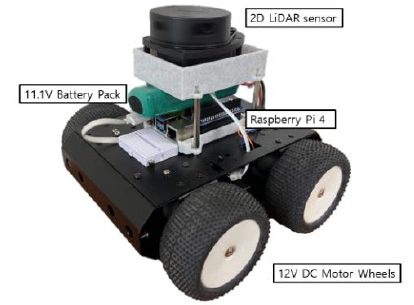
Figure 8. Autonomous Vehicle with LiDAR. Table 1. Specifications for Raspberry Pi and LiDAR.